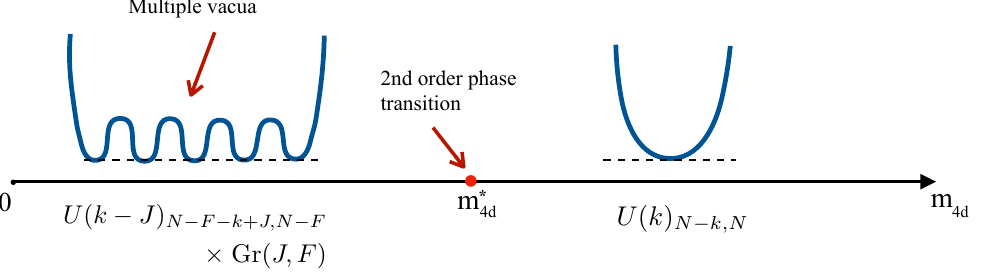
Figure 1: A qualitative picture of the phase diagram of k -walls of SU ( N ) SQCD with F < N flavors. In the small mass regime the k -wall theory has multiple vacua, parametrized by an integer J . In each vacuum, a topological theory is accompanied by a supersymmetric NLSM with target the complex